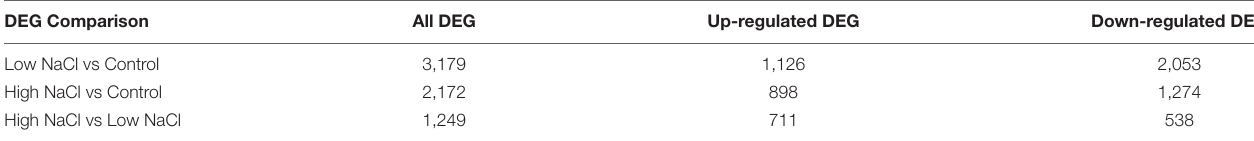
TABLE 2 | The number of upregulated and downregulated DEGs in leaves of P. antidotale under different salinity treatments. DEG Comparison All DEG Up-regulated DEG Down-regulated DEG Low NaCl vs Control 3,179 1,126 2,053 High NaCl vs Control 2,172 898 1,274 High NaCl vs Low NaCl 1,249